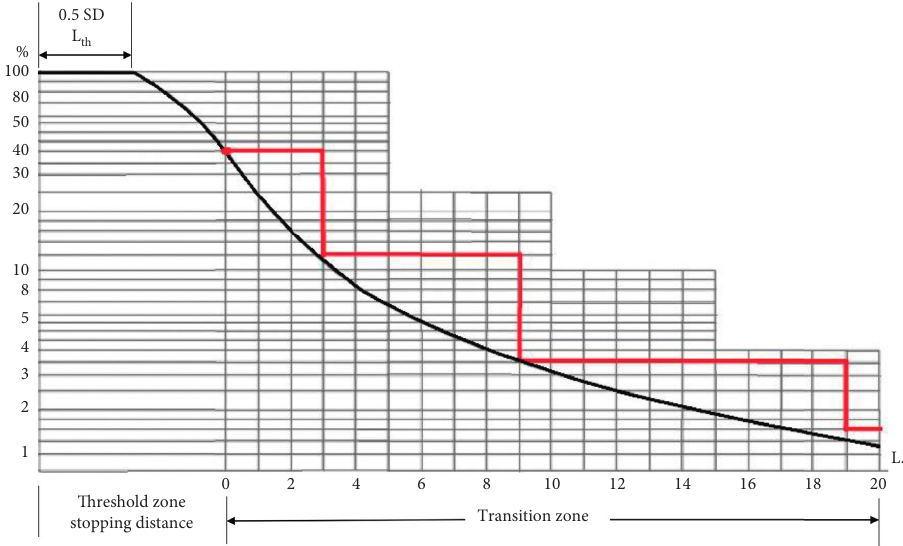
Figure 3: The black line is the luminance reduction curve for CIE 88: 2004 standard. The length of threshold zone � 0.5 SD, where L %. Threshold zone length � stopping distance (SD). The red lines indicate the target luminance in the zones of